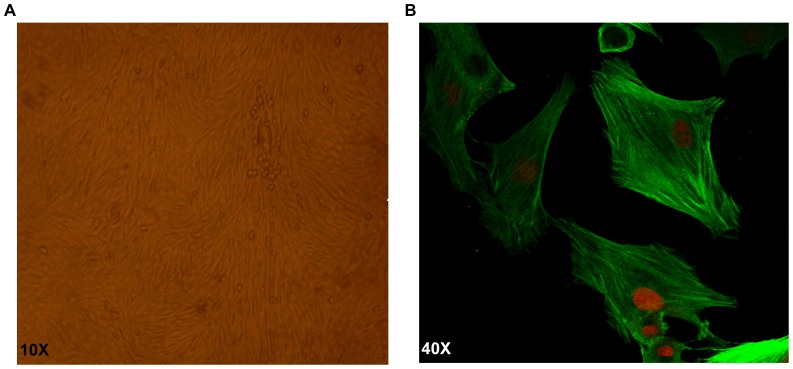
PASMCs morphology. A) Typical “hill and valley” appearance of PASMCs under phase contrast microscope. B) Immunofluorescent identification of α-smooth muscle actin was positive.